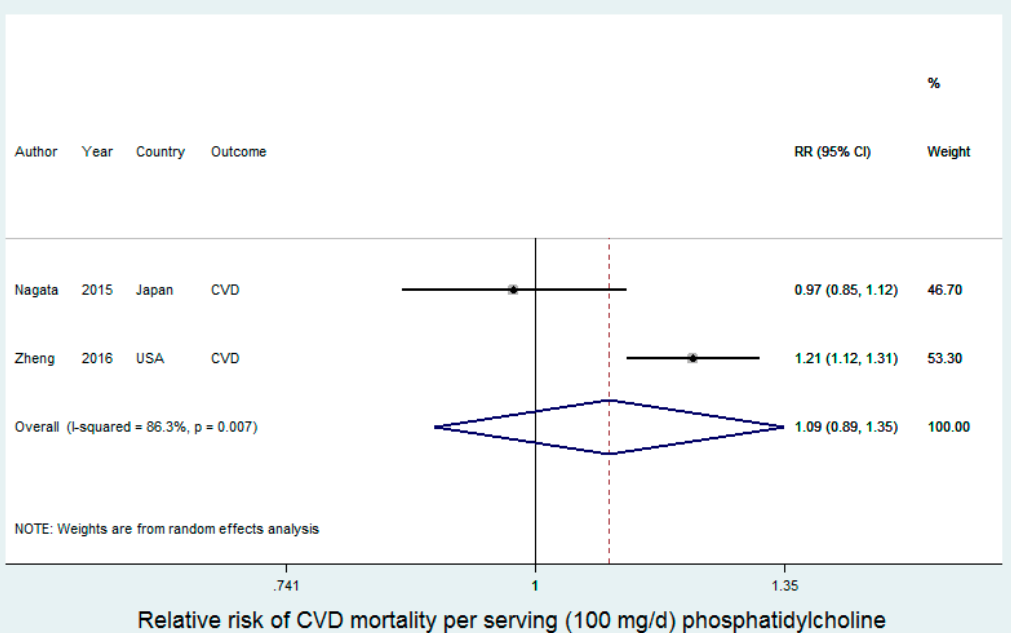
Figure 3. Phosphatidylcholine intake and CVD mortality.